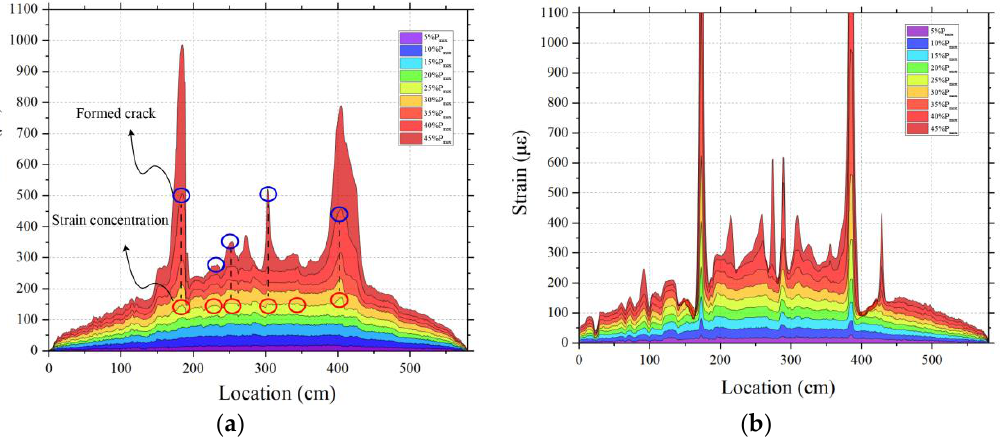
Figure 5. Strain profile at the bottom of precast prestressed bent cap under rising load: ( a ) Fiber V1 on side A; ( b ) Fiber J1 on Side